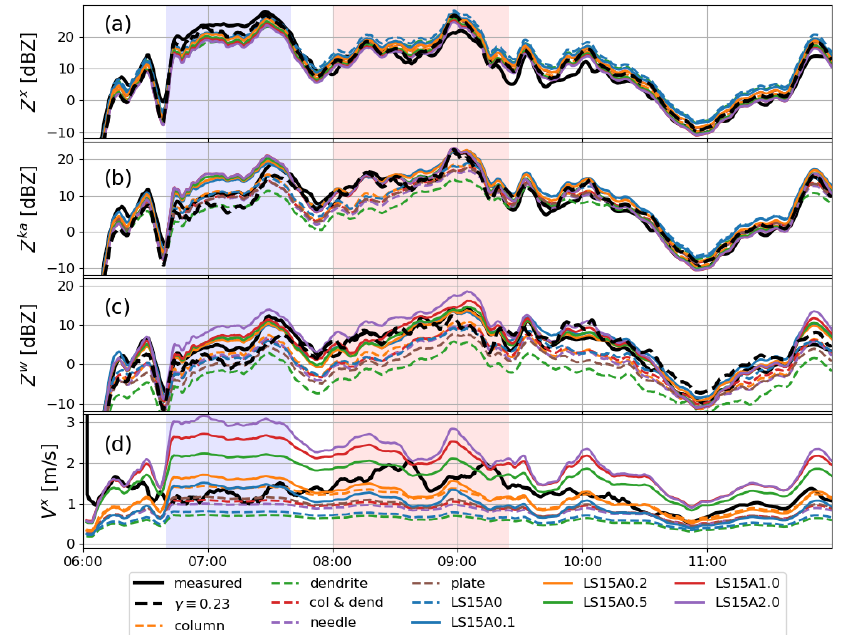
Figure 8. Measured (black lines) and simulated (colored lines) radar reflectivities at the X-, Ka-, W- and X-band MDV just above the melting level. The simulated values are predicted from the rain below the bright band by adopting the different snow models as listed in the legend. The black dashed lines show the reflectivity of snow derived with formula (8) for γ ≡ 0 . 23, i.e., the reflectivity corresponding to the MOSS hypothesis based on the radar reflectivity measured in rain and on MDV values in rain and ice (only X-band). Note that the difference between the continuous and the dashed black line is equal to γ n (Eq. 9).